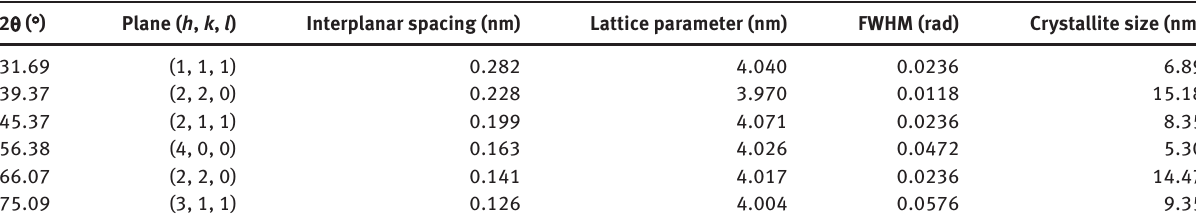
, 40 ° C, and 45 min) from the DSP extract. 3